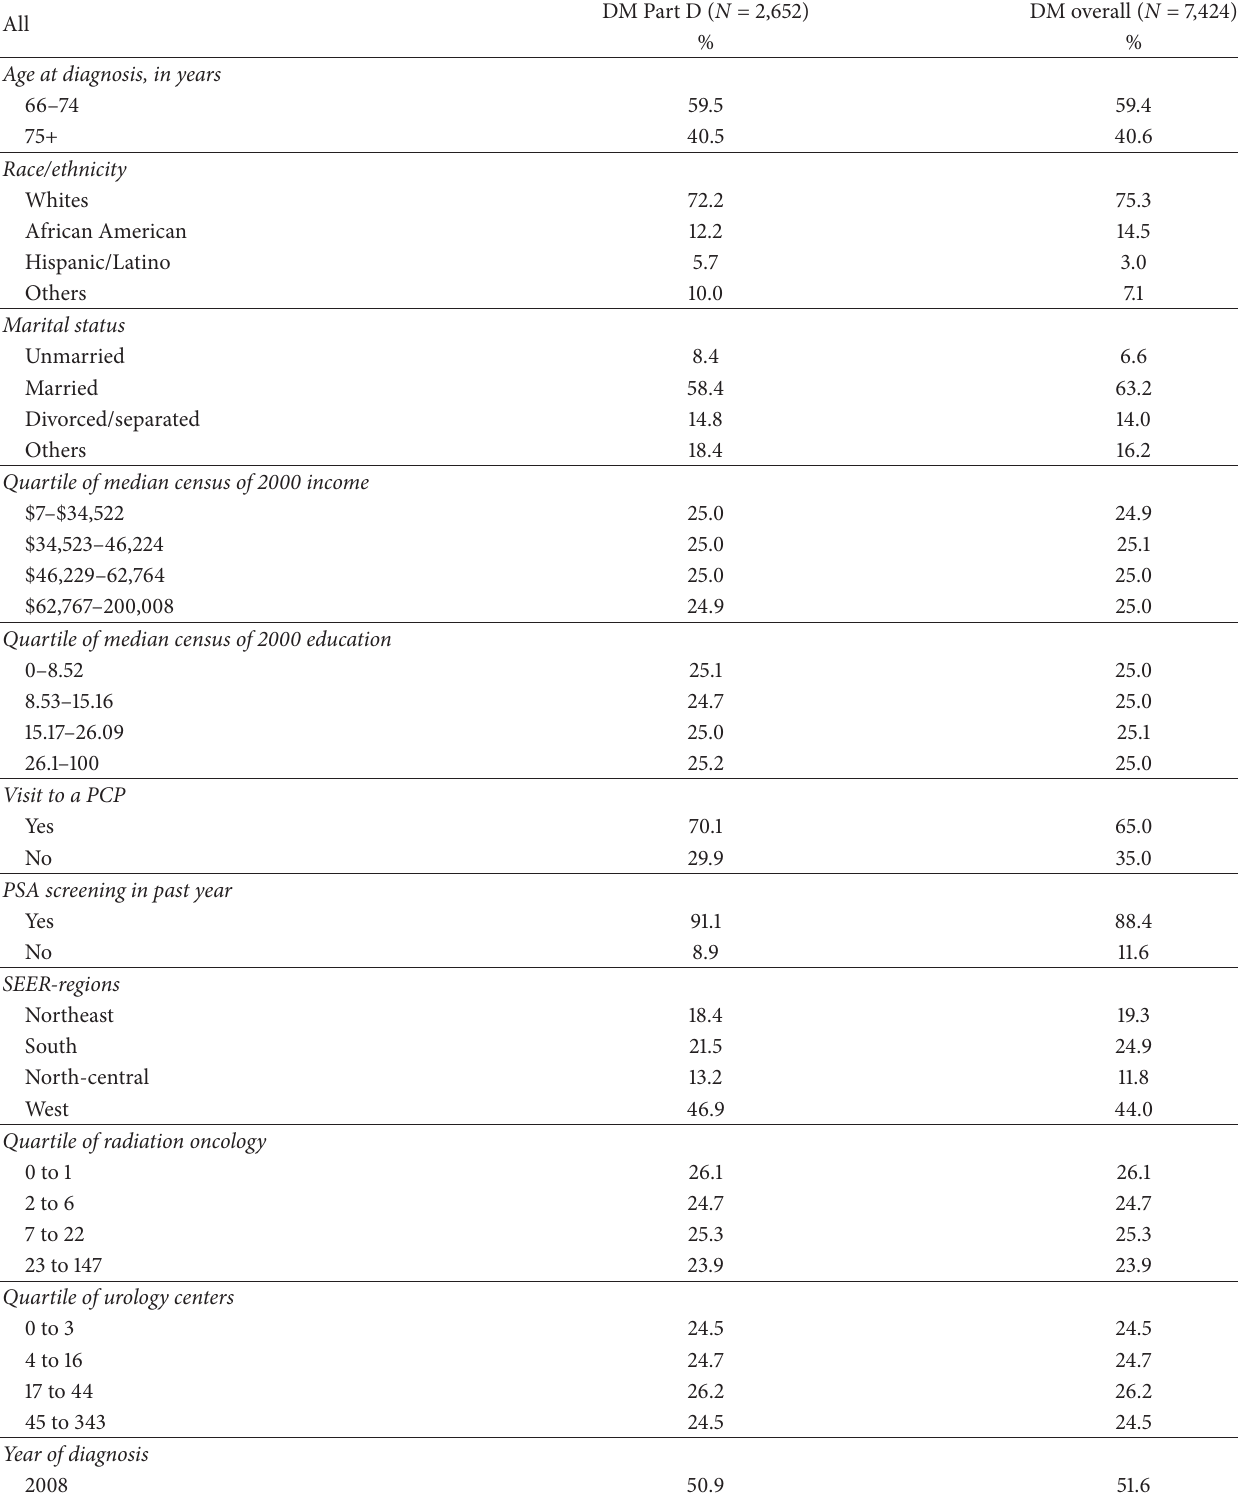
Table 5: Baseline characteristics of elderly men with prostate cancer with T2DM overall and enrolled in Part D program SEER-Medicare linked database,